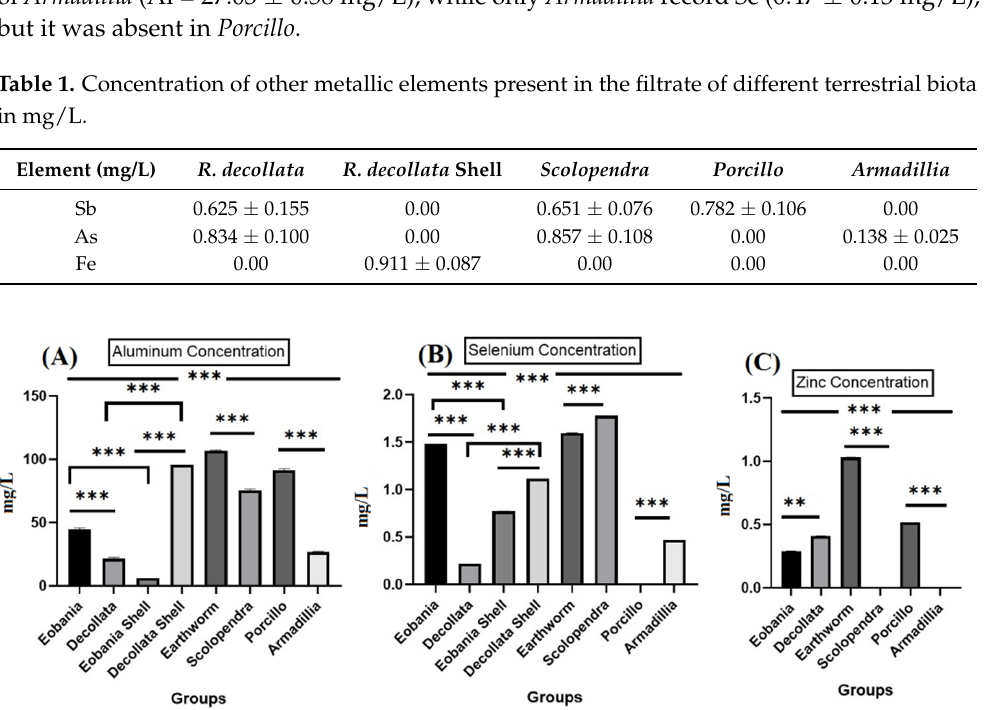
have higher Al concentration in comparison to Scolopendra